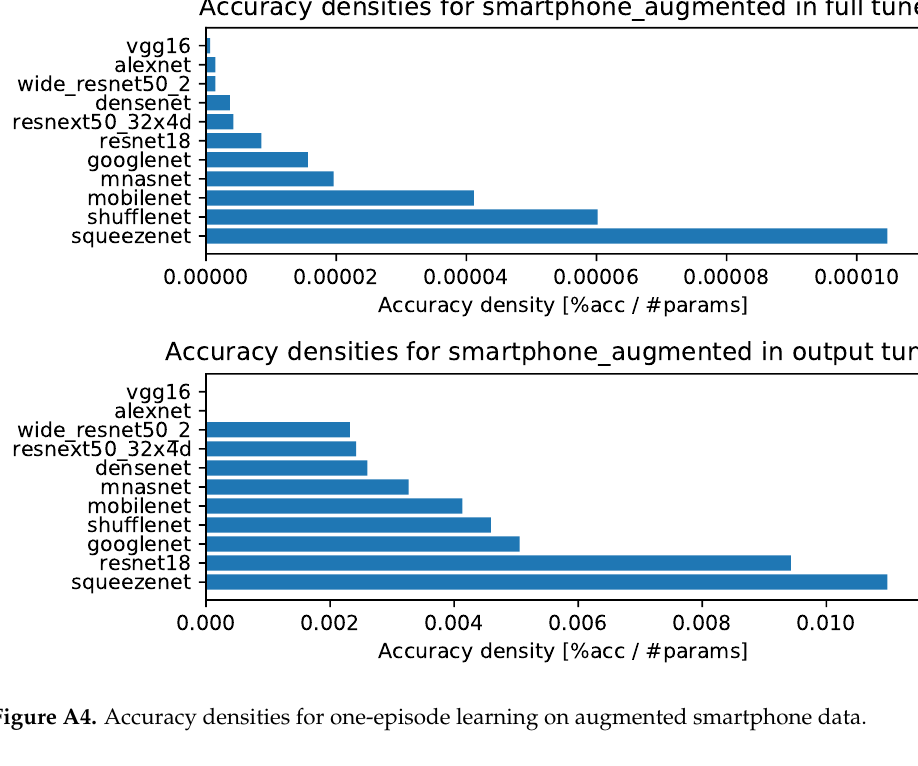
Figure A3. Accuracy densities for one-episode learning on MNIST.